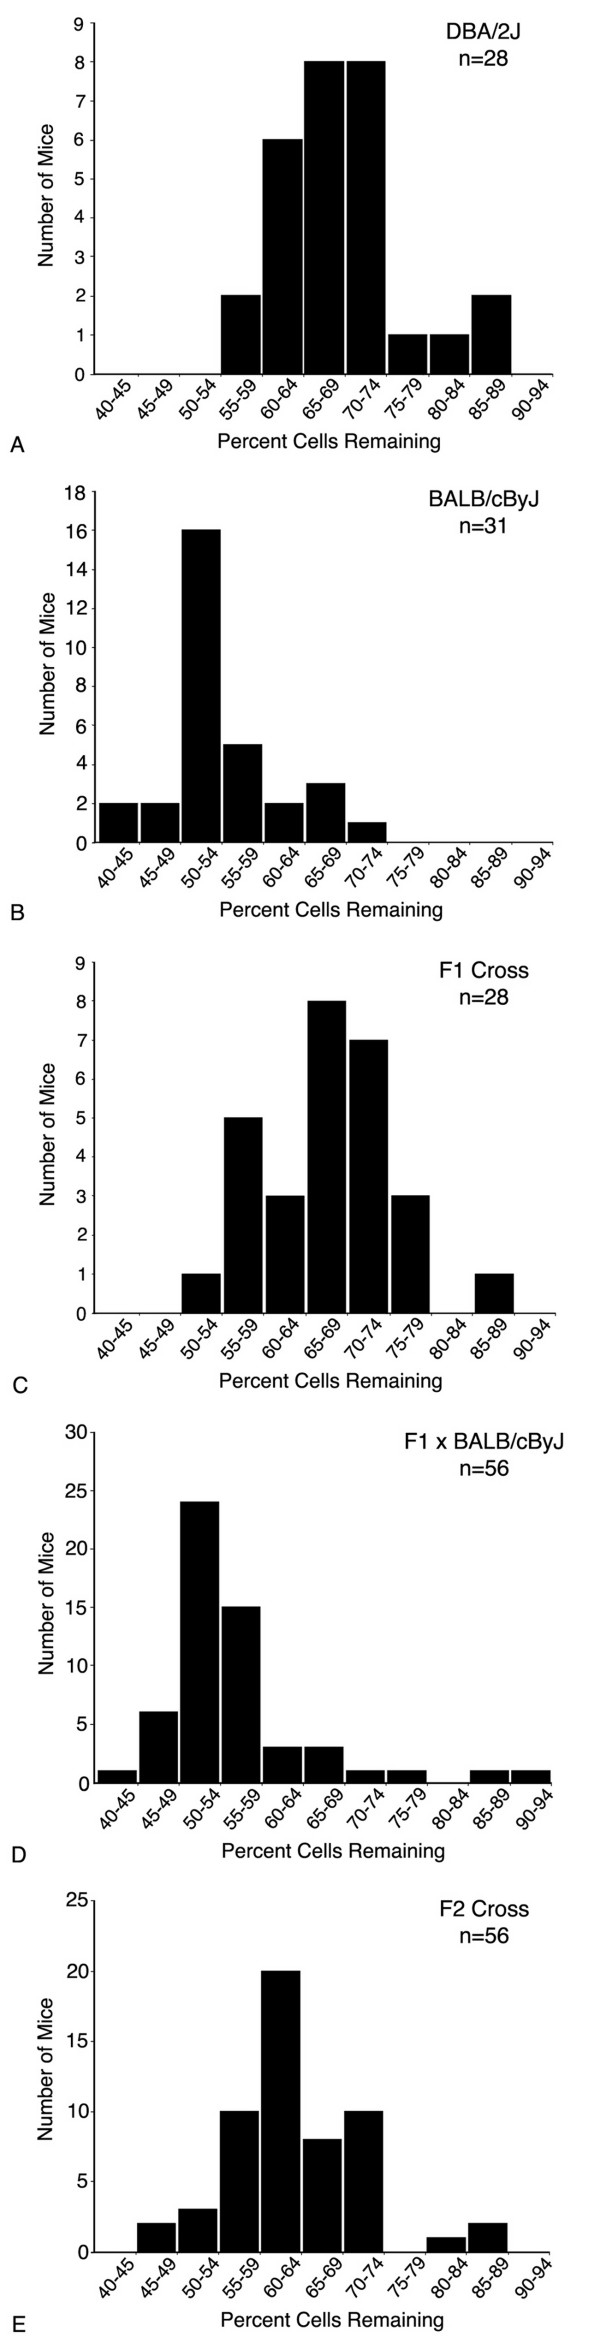
Resistance to optic nerve crush is heritable. Histographs showing the distribution of cell loss in 5 different populations of mice. (A) DBA/2J parental strain. (B) BALB/cByJ parental strain. (C) F1 generation of mice from DBA/2J and BALB/cByJ parents. These offspring inherit a level of resistance comparable to the DBA/2J parental strain. (D) N2 backcross generation of mice (F1 mice crossed with BALB/cByJ mice). These mice exhibit a shift toward the BALB/cByJ pattern of lowered resistance to optic nerve crush. (E) F2 generation of mice (F1 intercross). These mice exhibit an intermediate pattern of resistance.